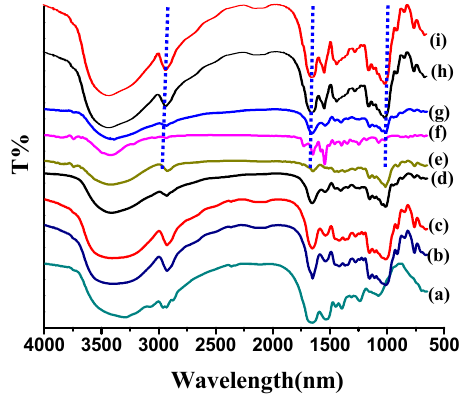
Figure 3. FTIR spectra of soy protein ( a ); NG1 ( b ); NG2 ( c ); NG3 ( d ); dextran ( e ); riboflavin ( f ); riboflavin-loaded NG3 ( g ); riboflavin-loaded NG2 ( h ) and riboflavin-loaded NG1 ( i ).